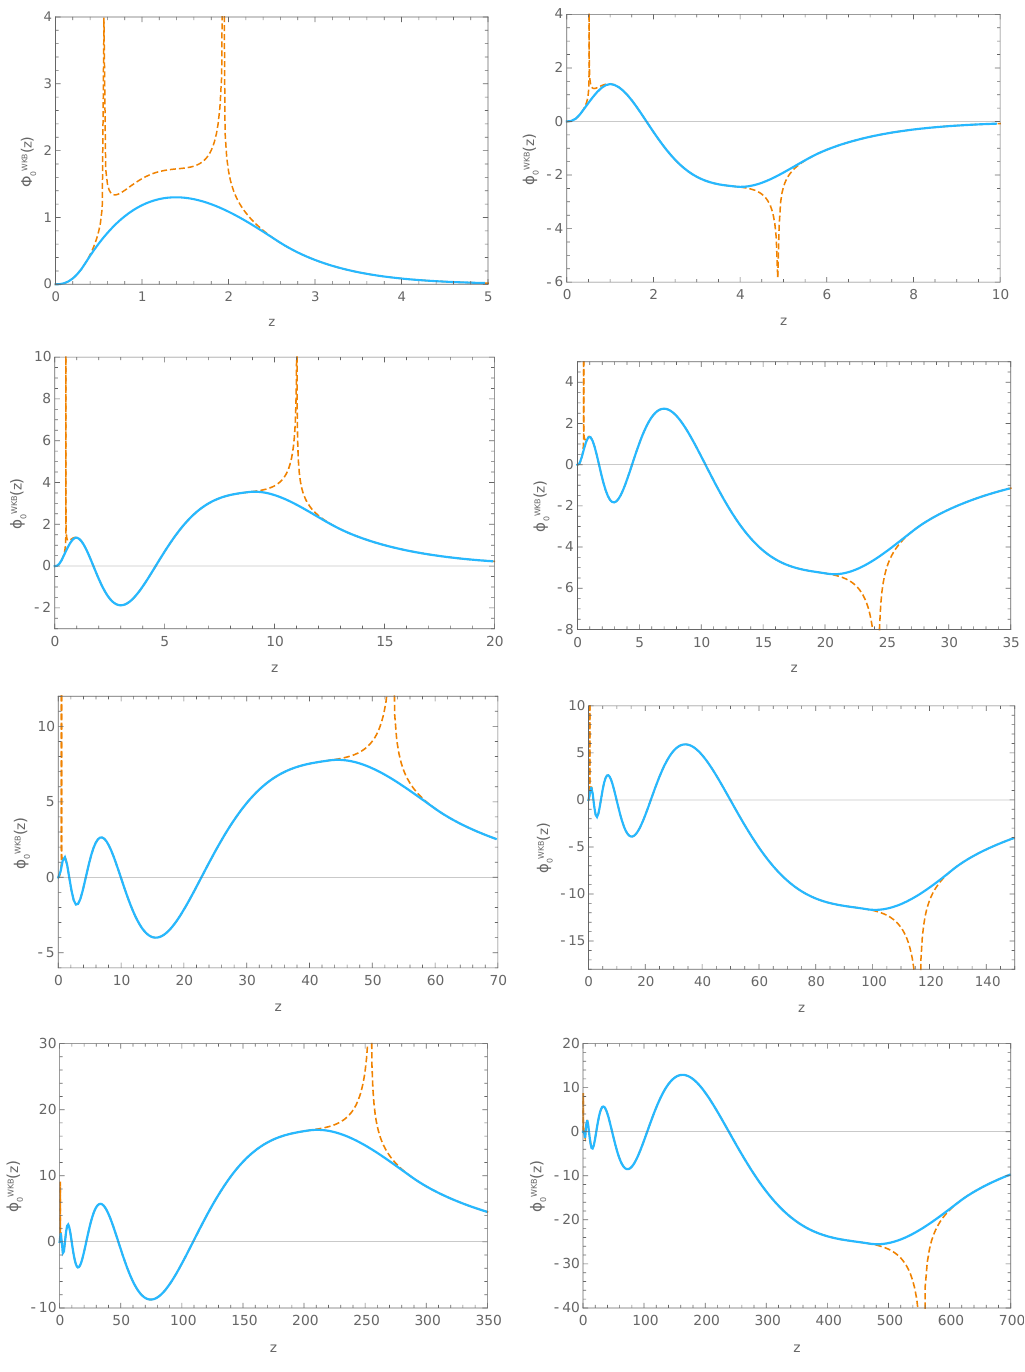
( z ) are shown for the values m ∈ { 0 , . . . , 7 } respectively. Figure 5 . Profiles of the function φ WKB m We see the smoothly interpolated solutions (light blue curves), and purely the WKB solutions (orange curves) that in the vicinity of the turning points were replaced by a quartic